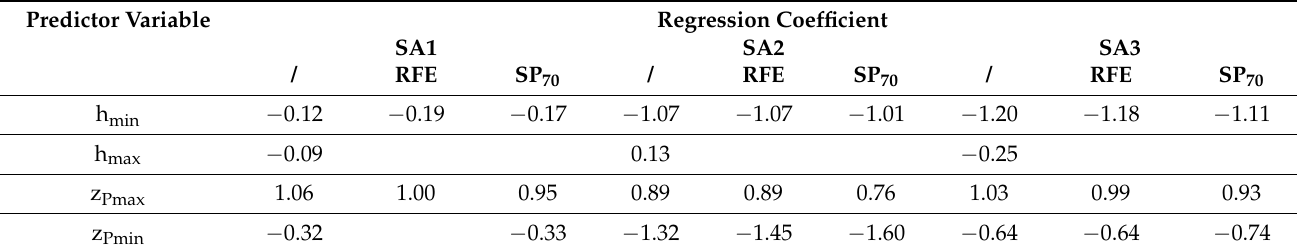
Table 6. Predictor variables used by the Logistic Regression classifier in SA1, SA2, and SA3. X indicates a predictor variable eliminated due to correlation. Variables are defined in Table